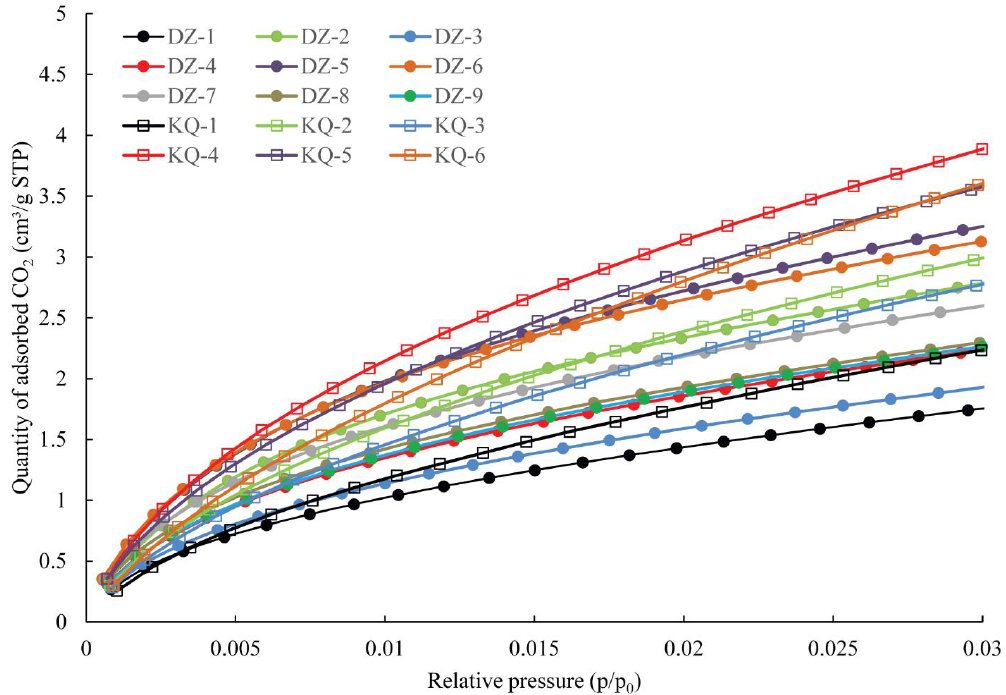
Figure 7. CO 2 adsorption isotherms of the studied Chang 7 Member shale samples.